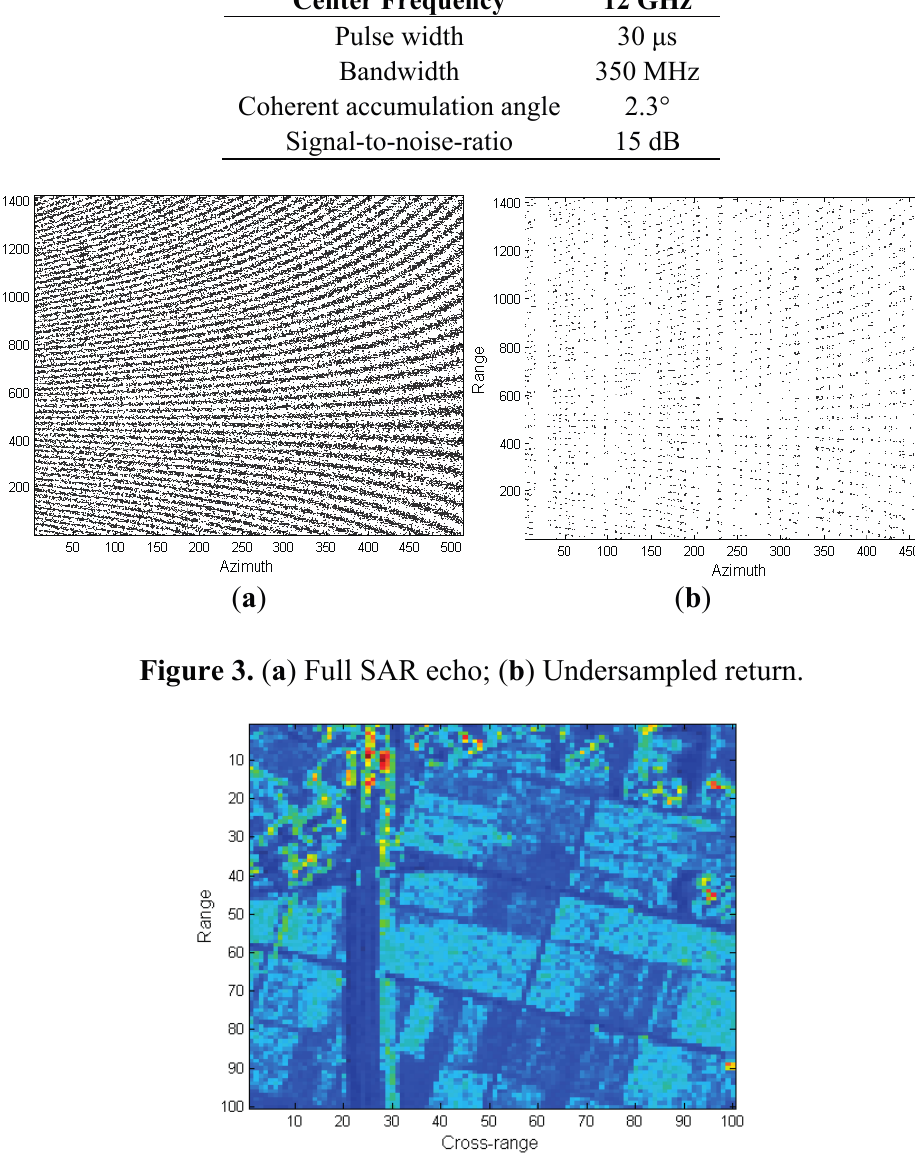
Figure 4. Image recovered from full